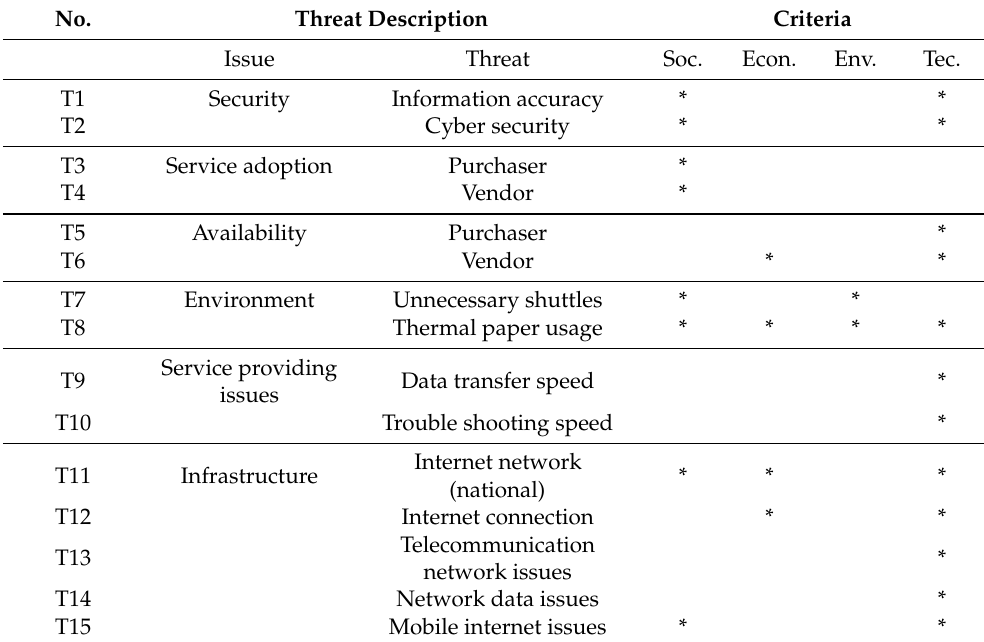
Table 3. ‘Pure Threat’ cluster elements: a * shows that the factor Ti pertains to the criterion on top. No. Threat Description Criteria Issue Threat Soc.